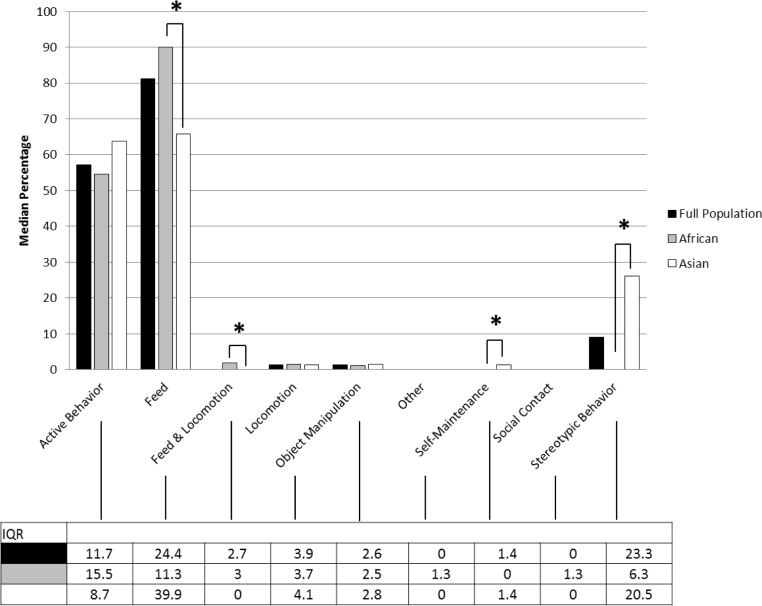
Median nighttime active behavioral observation percentages and interquartile ranges.Asterisks represent significant species differences (p<0.05). For the full population, median values for Feeding & Locomotion, Other, Self-Maintenance, and Social Contact were zero. For African elephants, median values for Other, Self-Maintenance, Social Contact, and Stereotypic Behavior were zero. For African elephants, median values for Feeding & Locomotion, Other, and Social Contact were zero.